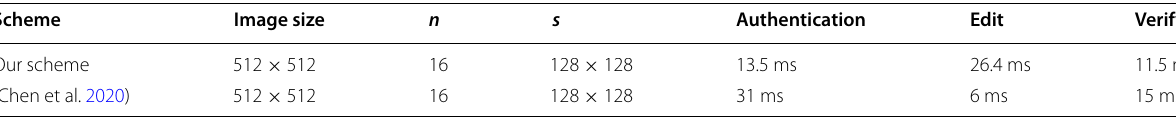
n : the number of areas, m : the number of edited areas, s : the size of the areas